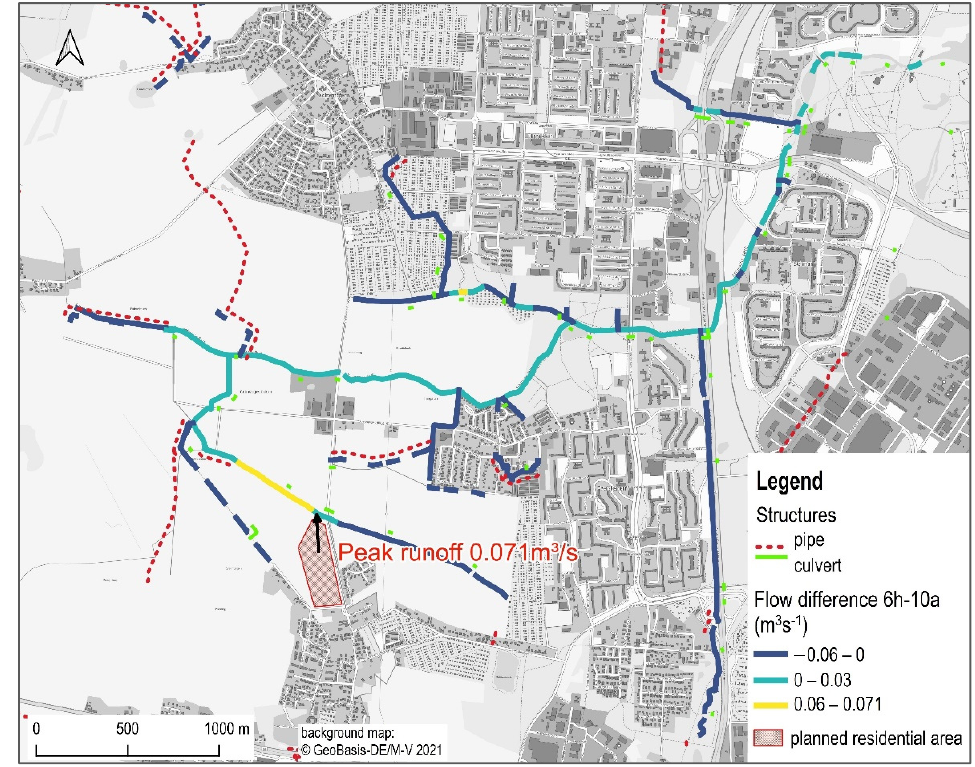
Figure 7. Difference of flows (m 3 s − 1 ) in planned and current state for the rain event 6h-10a simulated with SWMM (pipes and culverts are plotted with offset to original route).